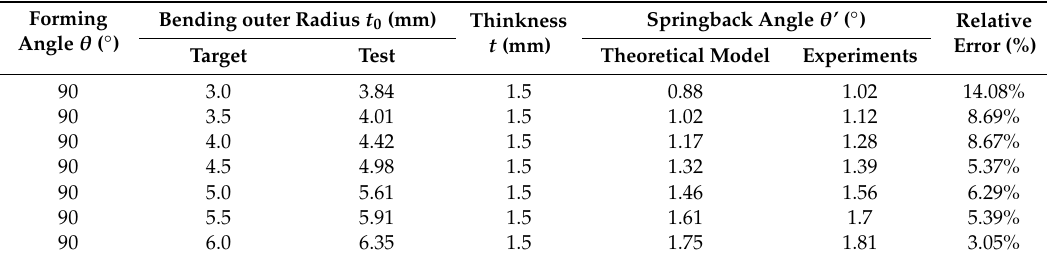
Figure 15. E ff ect of the bending radius on springback control: ( a ) E ff ect of bending outer radius. Figure 15. Effect of the bending radius on springback control: ( a ) Effect of bending outer radius. ( b ) ( b ) Setpoints and actual values of bending outer radius. Setpoints and actual values of bending outer radius. Table 3. Comparison of theoretical and test values under di ff erent bending